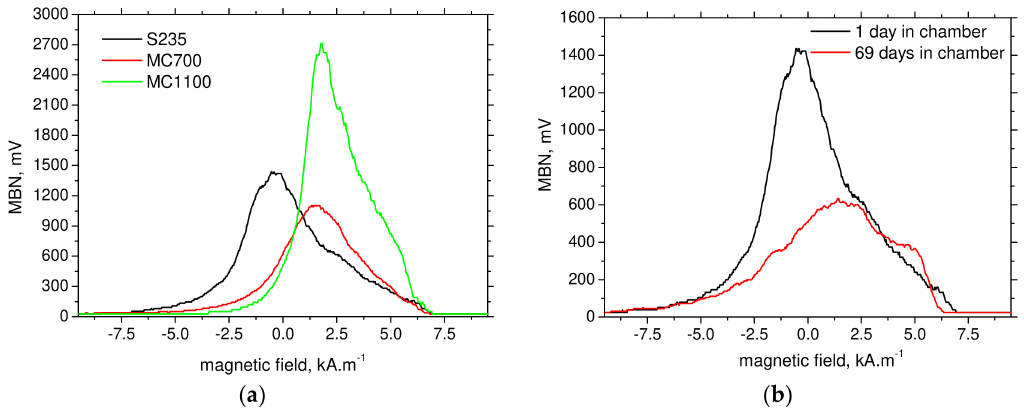
Figure 7. MBN envelopes. ( a ) 1 day in the chamber-RD, ( b ) S235-RD.